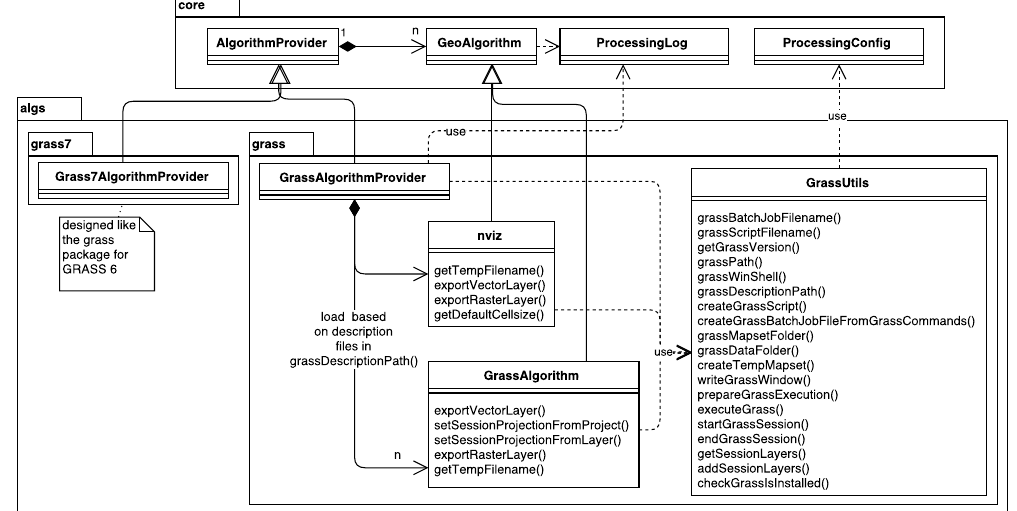
Figure 12. Class diagram of the grass and grass7 packages and their connections to other